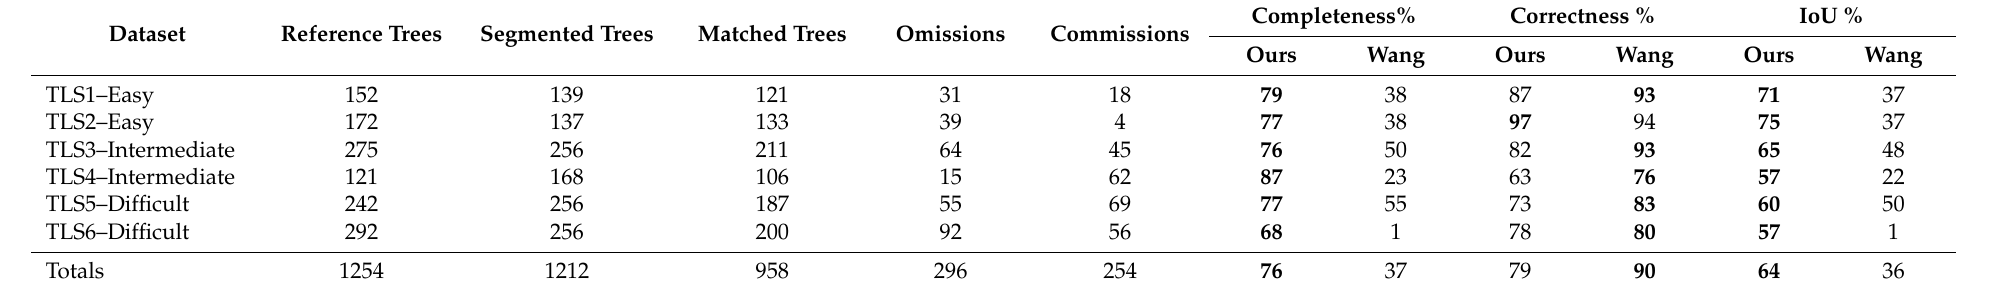
Table 5. Tabulated segmentation results achieved by our UCRP algorithm, and comparison of our algorithm and the SOTA algorithm [15] on the International TLS Benchmarking Datasets. Bold indicates the best performer.